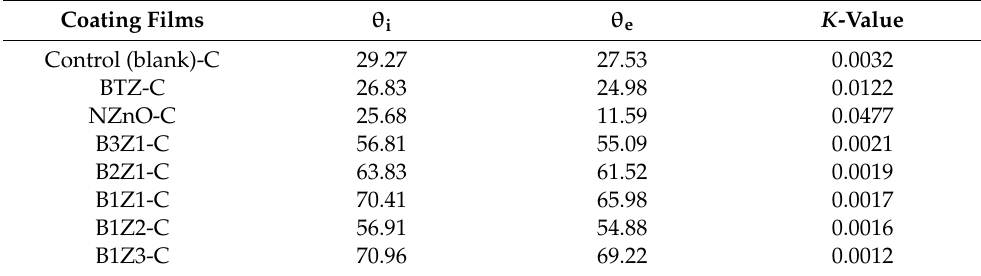
Figure 6. Time dependence of dynamic contact angle of deionized water on film surfaces. Table 3. Initial and equilibrium contact angles and K -values of deionized water on film